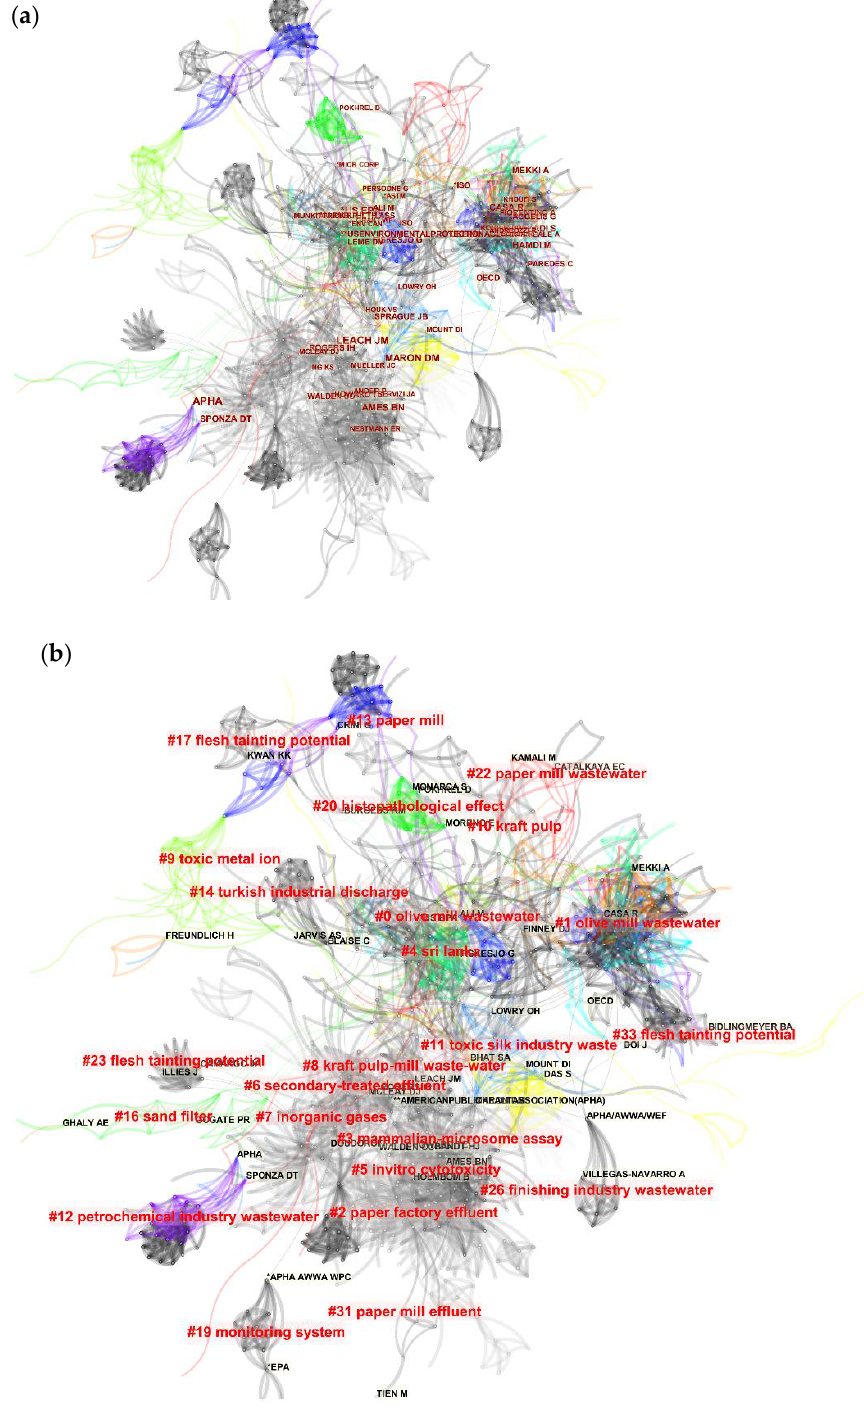
Figure 9. The obtained results from the analysis of the cited authors and organizations contributing to the field of industrial effluent and sludge toxicity from 1951 to 2020. Both illustrations ( a , b ) have been achieved via the utilization of CiteSpace software. Figure ( a ) represents the cited authors in this field, while figure ( b ) illustrates the clustering applied to the most cited